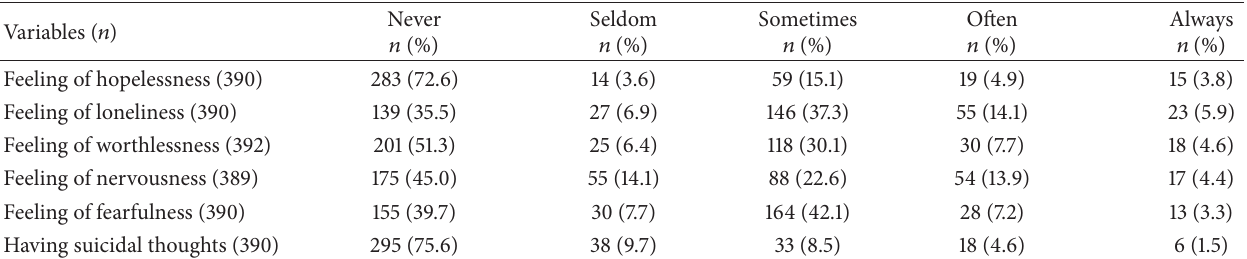
Table 3: The drug users’ psychotic symptoms after methadone therapy and learning social-emotional skills for six months. Variables ( 𝑛